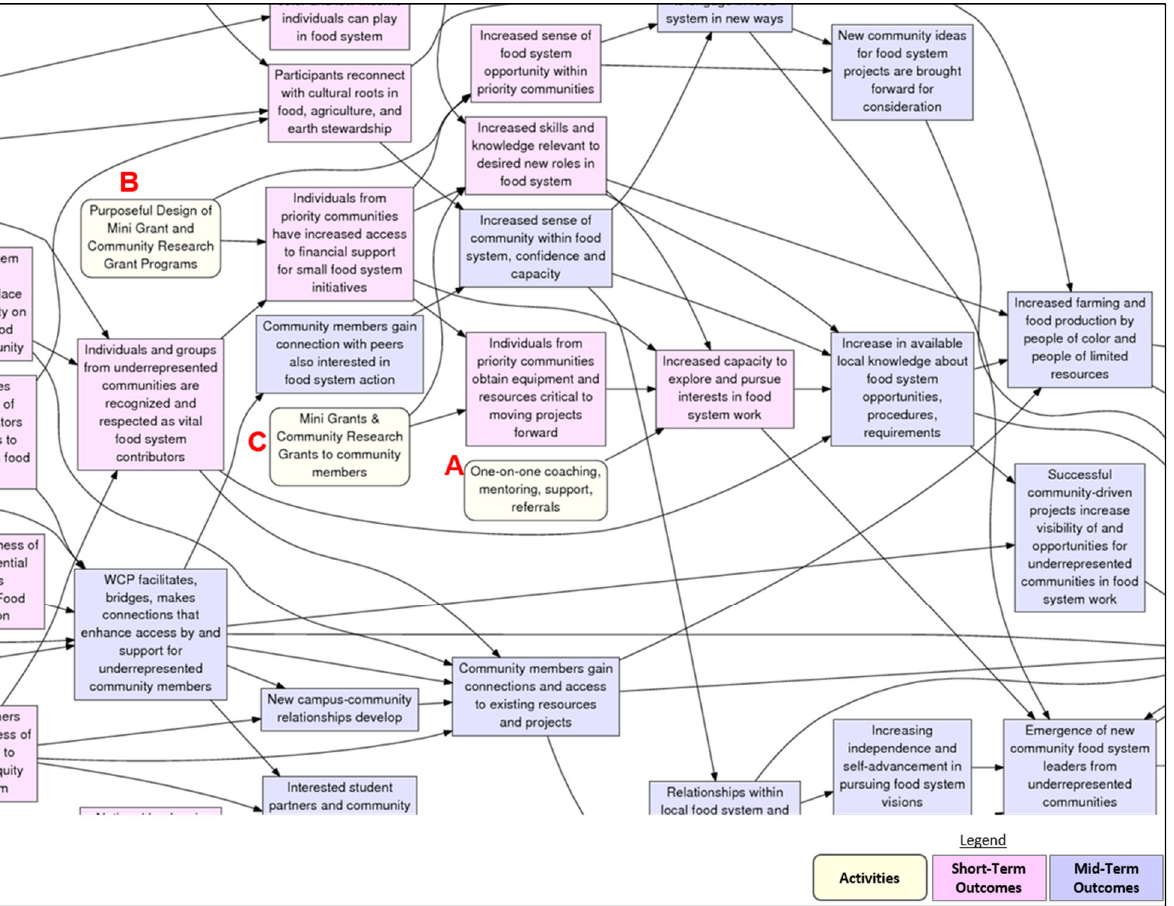
Figure A4. Subsection of Whole Community Project (WCP)’s Collaborative Pathway Model Relating to